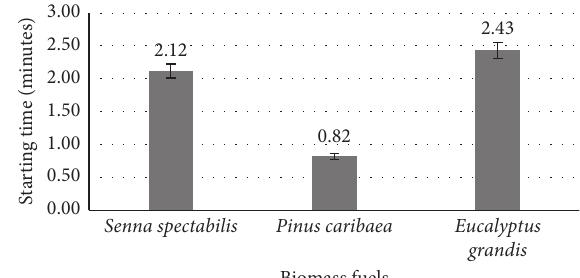
Figure 6: Average time of starting biomass fuels.